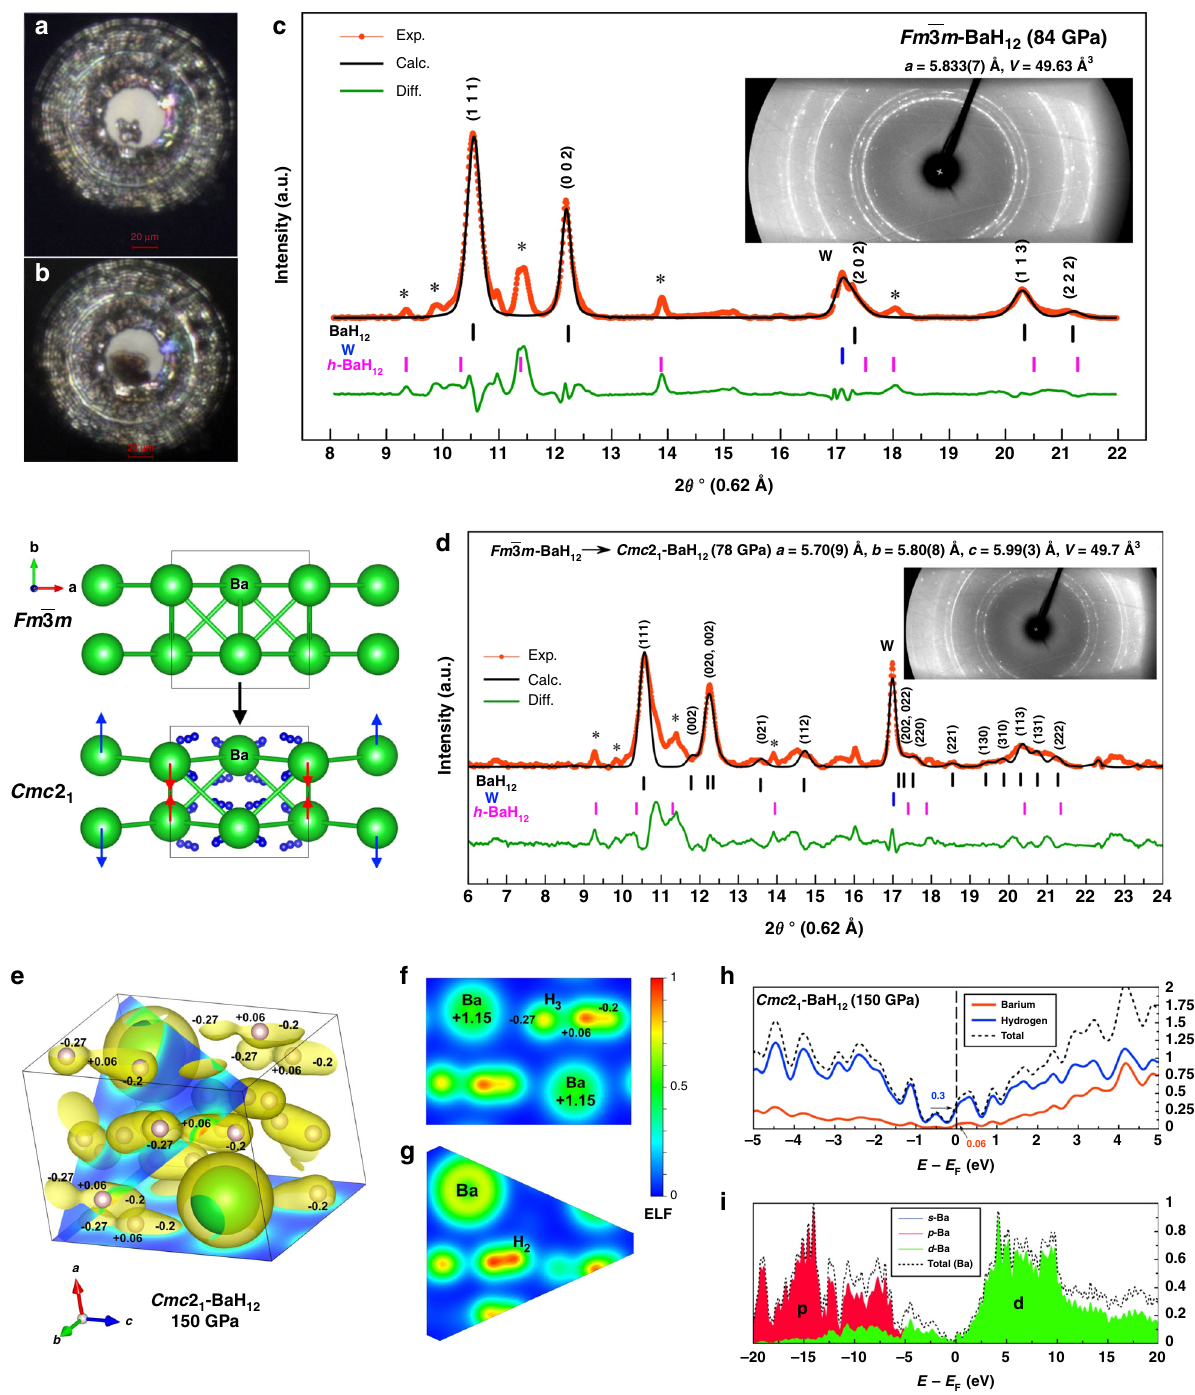
Fig. 4 Low-pressure synthesis and physical properties of BaH 12 . Loaded Ba/AB sample a before and b after the laser heating in DAC #B3. Experimental XRD pattern and the Le Bail re fi nement of c the ideal Fm (cid:1) 3 m- BaH 12 structure at 84 GPa and d Cmc 2 1 -BaH 12 obtained via the distortion of Fm (cid:1) 3 m -BaH 12 . The re fl ections indicated by asterisks may correspond to unidenti fi ed hexagonal barium polyhydride BaH ~12 . The experimental data, model fi t for the structure, and residues are shown in red, black, and green, respectively. e Electron localization function (ELF), projected onto f the (100) plane and g the ð 11 (cid:1) 1 Þ plane, and Bader charges of the Ba and H atoms in Cmc 2 1 -BaH 12 at 150 GPa. h Contribution of barium and hydrogen to the electronic density of states of BaH 12 . i d-character of Ba electrons near the Fermi